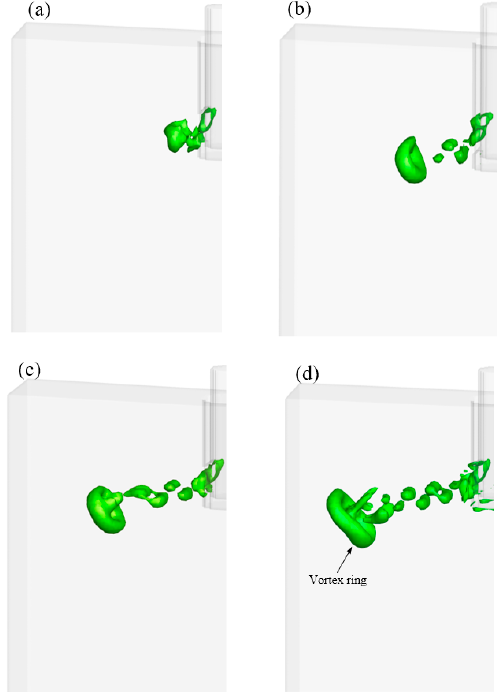
Figure 4. Development of the vortex structure in the jet flow region across the width of the mold at different times of ( a ) 0.2 s, ( b ) 0.3 s, ( c ) 0.4 s, and ( d ) 0.5 s.